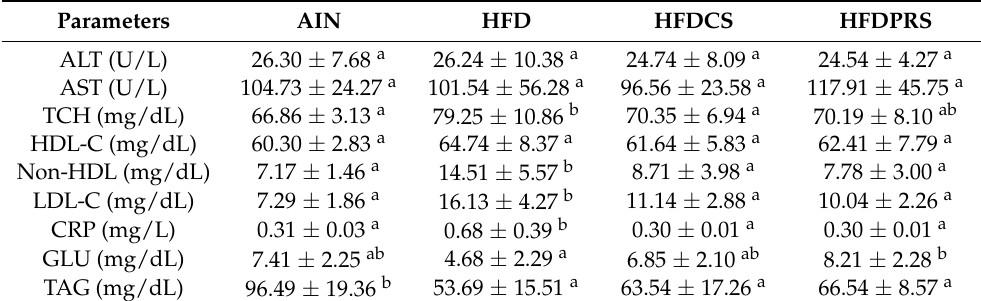
The mean values with different letters in the row are statistically different ( p < 0.05). “ ± ” indicates standard deviation. Each group consisted of ( n ) eight rats. AIN—group fed with the basic diet AIN-93M; HFD—group fed with the basic diet AIN 93M with the addition of lard; HFDCS—group fed with the basic diet AIN-93M with the addition of lard and lyophilisate from control sprouts; HFDPRS—a group fed with the basic diet AIN-93M with the addition of lard and modified buckwheat sprouts lyophilisate.